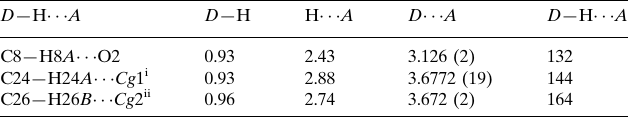
Hydrogen-bond geometry (A˚ , (cid:2)